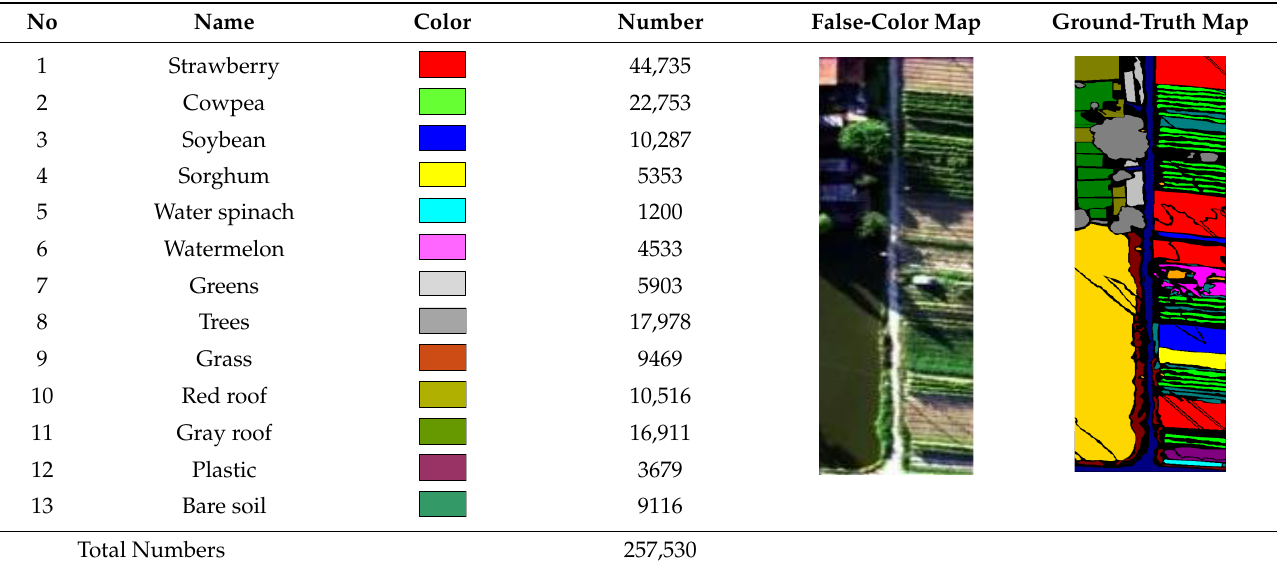
Table 2. KSC Dataset Labeled Sample Counts.